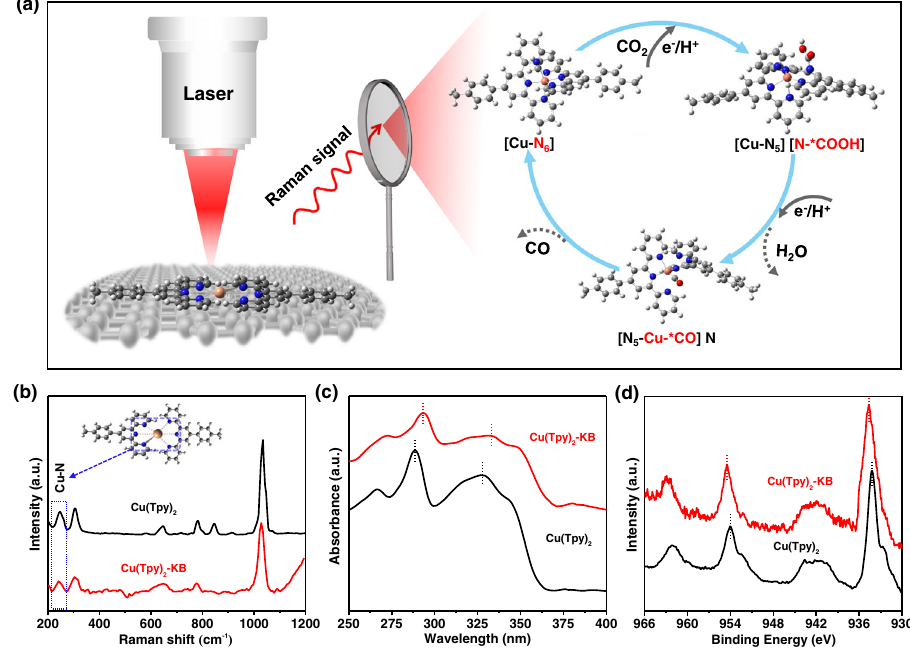
Fig. 1 | Schematic representation of the operando Raman analysis used in this study and the physicochemical characteristics of Cu(Tpy)2 and Cu(Tpy)2-KB. a A scheme illustrating the operando Raman study on the CO 2 RR process of